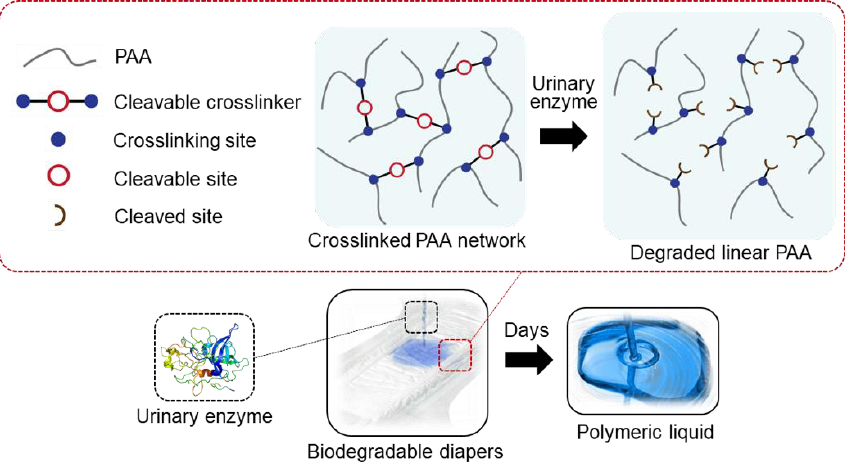
Figure 1. A schematic illustrating the enzymatic degradation of the SAP created using the cleavable crosslinker.